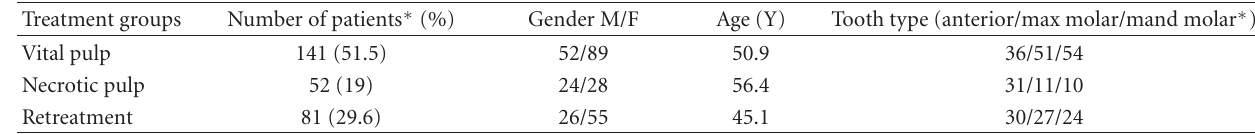
Table 1: Patient distribution according to gender, age, and treated teeth for each of the treatment groups.